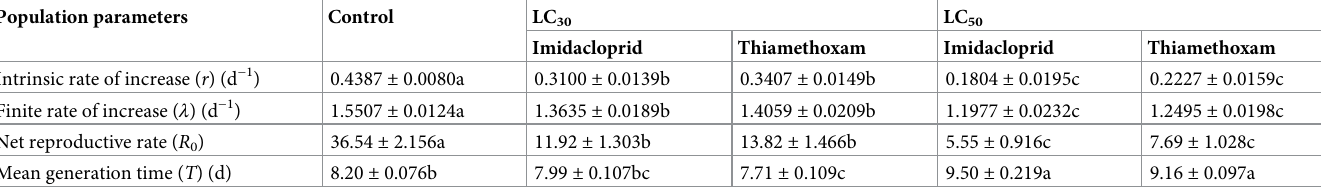
Means ( ± SE) followed by different letters in the same row are significantly different as calculated using the paired bootstrap test at the P < 0.05 level. Leaves treated with distilled water were used as the